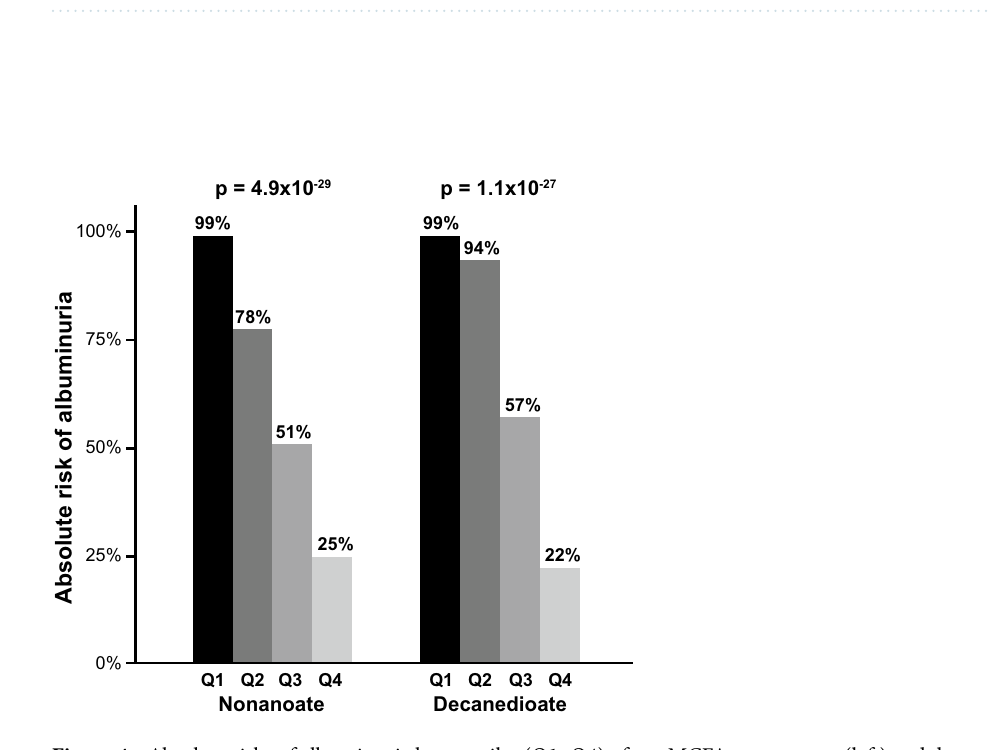
Figure 4. Absolute risks of albuminuria by quartiles (Q1–Q4) of top MCFAs: nonanoate (left) and decanedioate (right). Chi-square test p values are